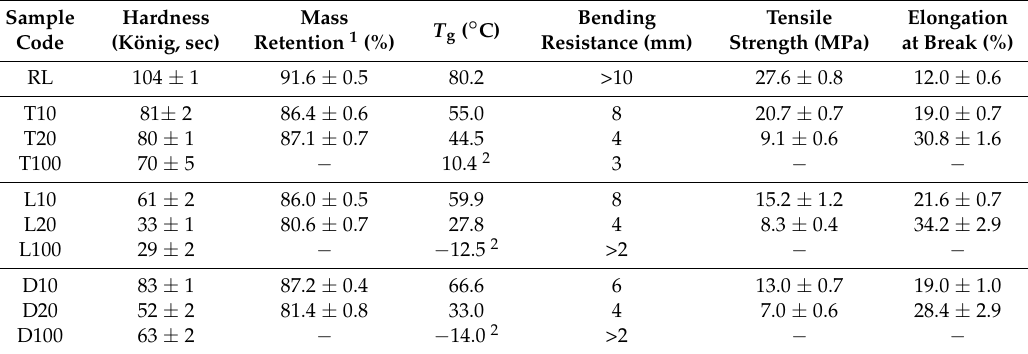
Table 2. The hardness, mass retention, T g , and bending resistance of oil-modified refined lacquer (OMRL)